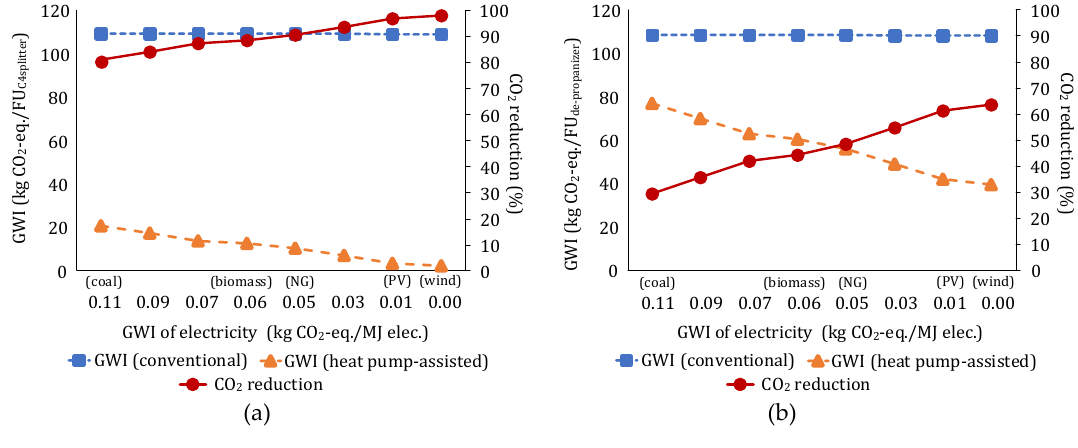
Figure 9. GWI (global warming impact) in kg CO 2 -equivalents (kg CO 2 -eq.) per functional unit (FU). Effect of the GWI of electricity for the ( a ) C4 splitter and ( b ) de-propanizer in conventional and heat pump-assisted distillations.